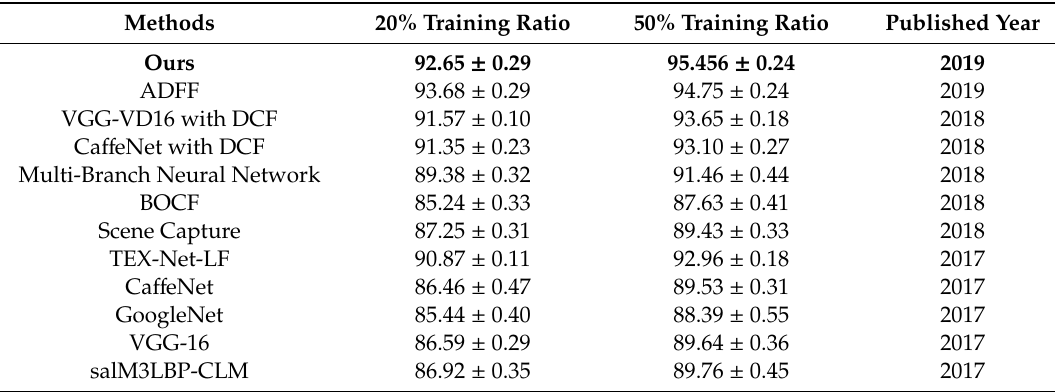
Table 3. The overall accuracy (OA) of the models on AID